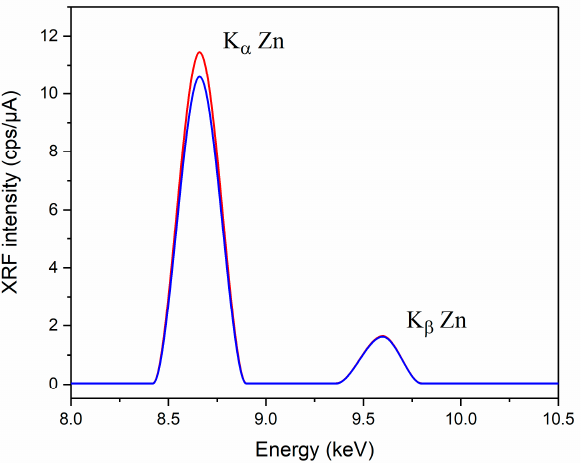
Figure 5. XRF spectra of synthesized Zn(Met) 2 (red) and crystallized Zn(Met) 2 (SO 4 ) x complexes (blue) at the characteristic energy of zinc fluorescence—zinc K α line of 8.632 keV and zinc K β line of 9.572 keV.